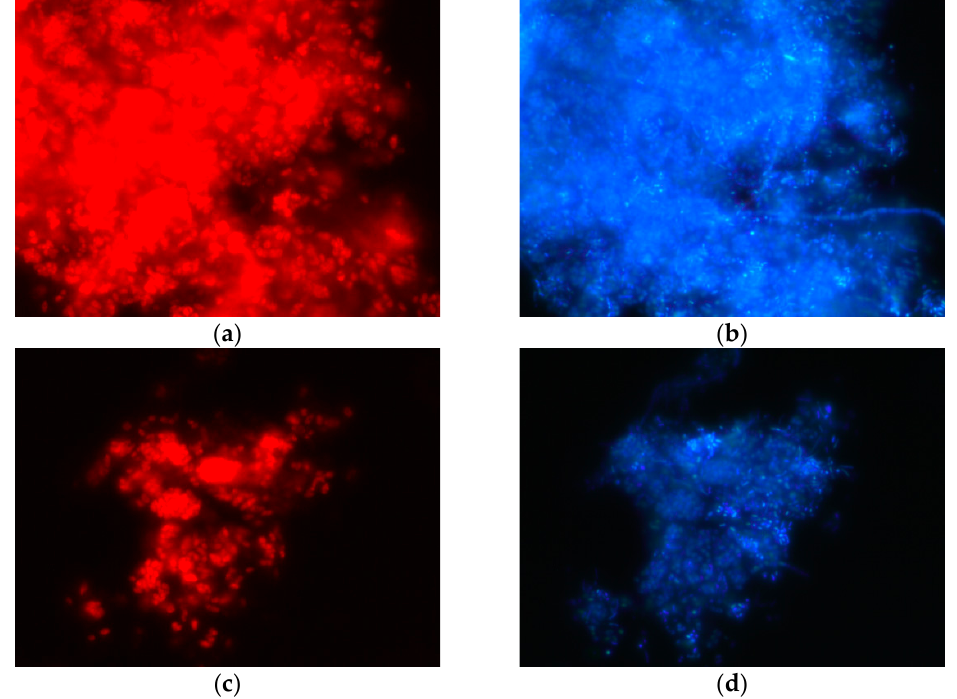
Figure 2. The fluorescence in situ hybridization (FISH) identification of polyphosphate-accumulating organisms (PAOs) with Cy-3 labelled PAOMIX (PAOs depicted in red in ( a , c ), all microorganisms stained with DAPI depicted in blue in ( b , d )).